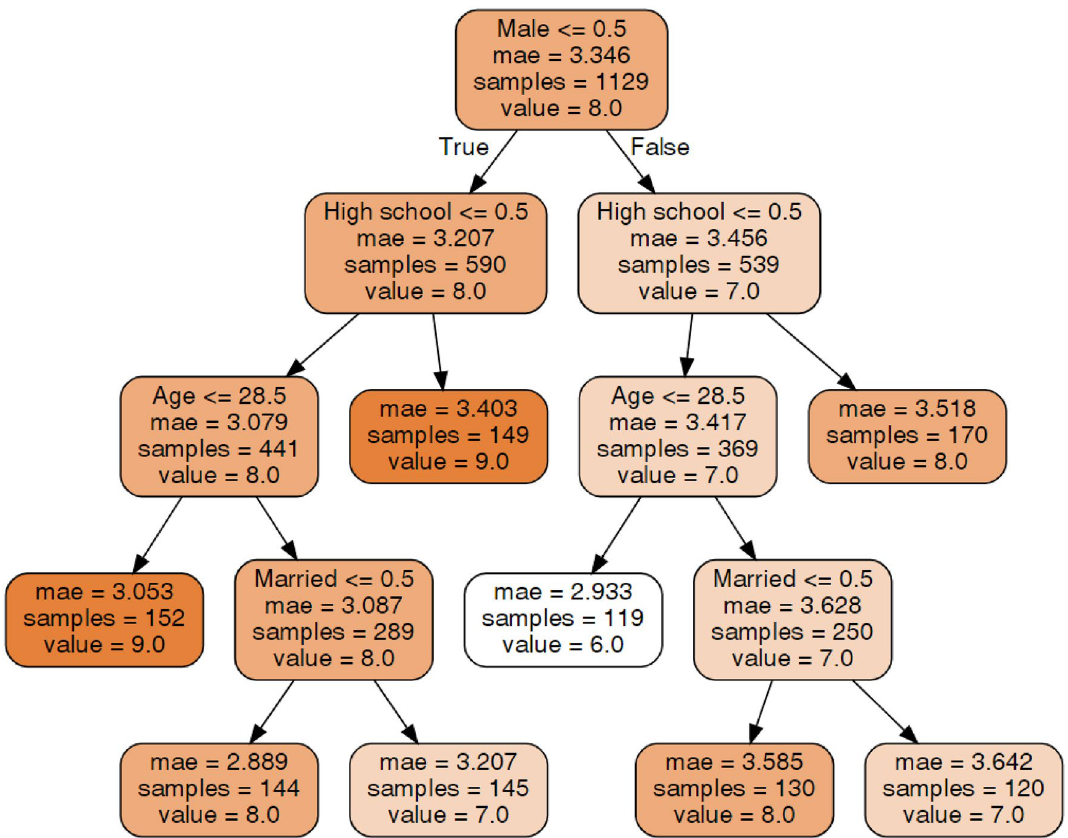
Figure 2. Decision tree for Hospital Anxiety and Depression Scale (HADS) Depression. Source: author- generated tree using the sklearn and graphviz